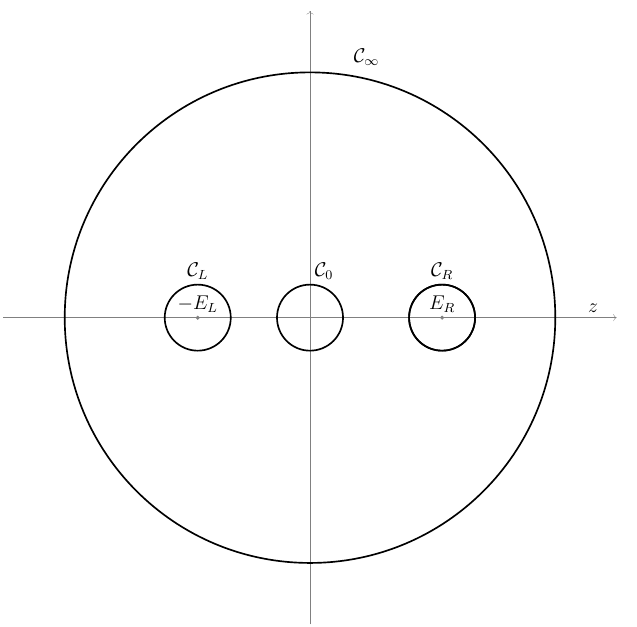
˜ ψ ( z ) at the origin to its residues